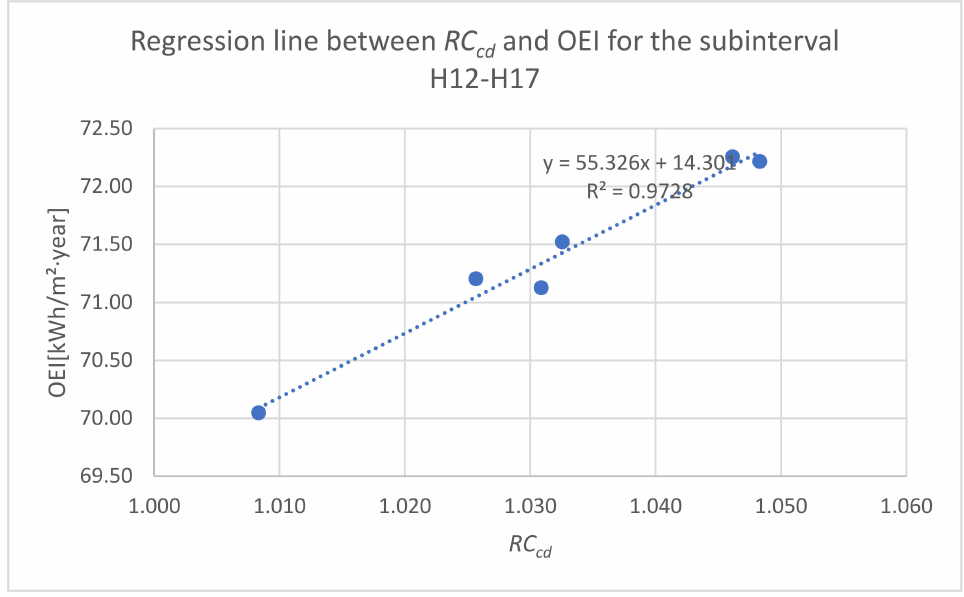
Figure 7. The relative compactness index RC cd measures the size of OEI very